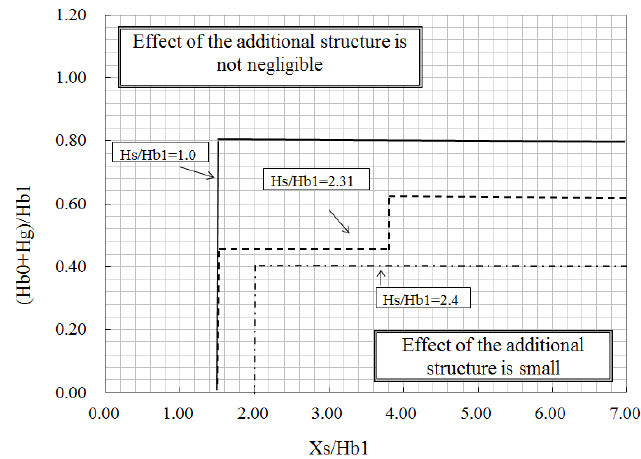
Figure 6. Effect of additional structure on effective stack height when Hs/Hb1 < 2.5.